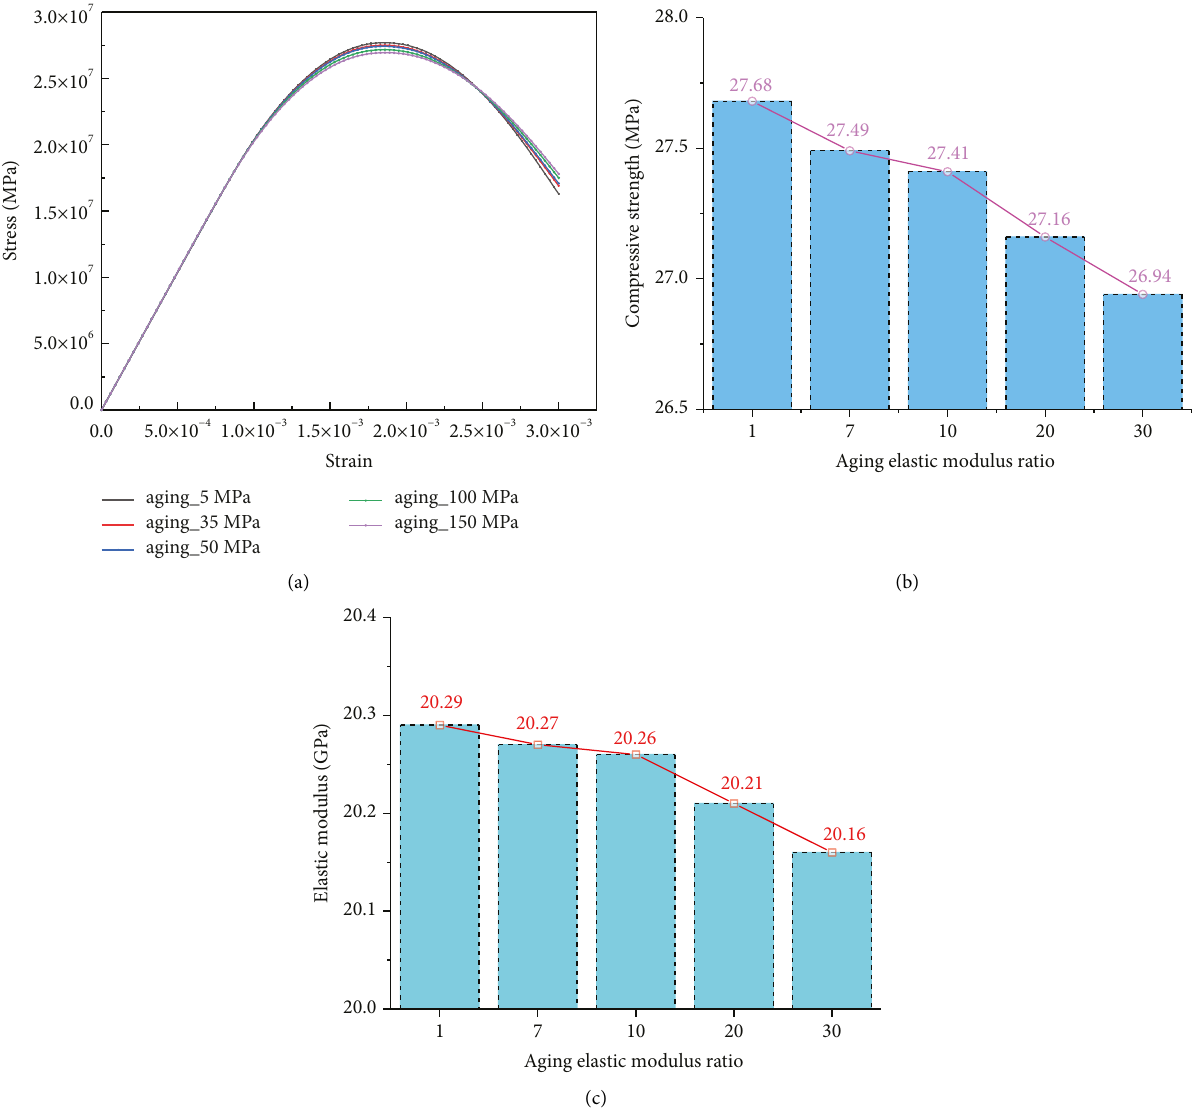
Figure 6: Compressive properties of rubberized concrete with different aging levels. (a) Stress-strain relation, (b) compressive strength, (c) elastic modulus. Table 3: Table of elastic modulus and compressive strength of concrete with different aging elastic modulus ratio. Mechanical